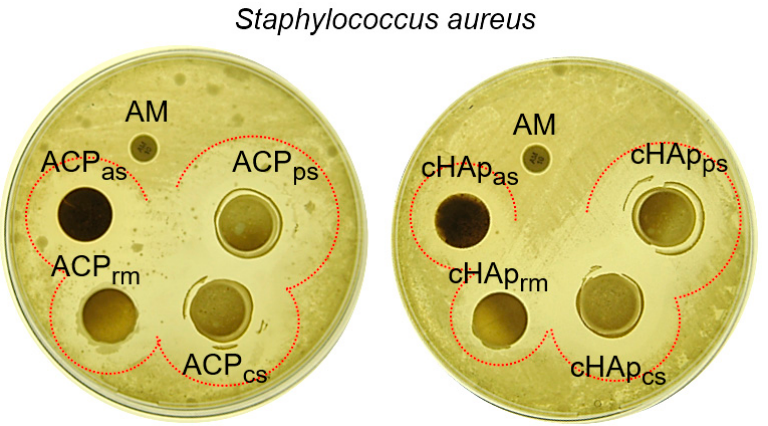
Figure 7. Inhibition of Staphylococcus aureus growth by STR. Antibacterial activity is shown by the formation of the inhibition halos; the bacterial strain is very sensible to STR. AM, commercial ampicillin disk. The dotted lines show the inhibition zones.